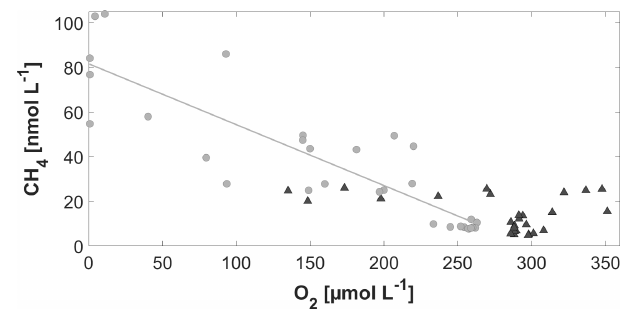
Figure 9. Comparison of the relationship of CH 4 vs. O 2 in June (black triangles; p = 0 . 07) and September (filled grey circles; y = − 0 . 2729 x + 81 . 65; R 2 = 0.764; p = < 0 .